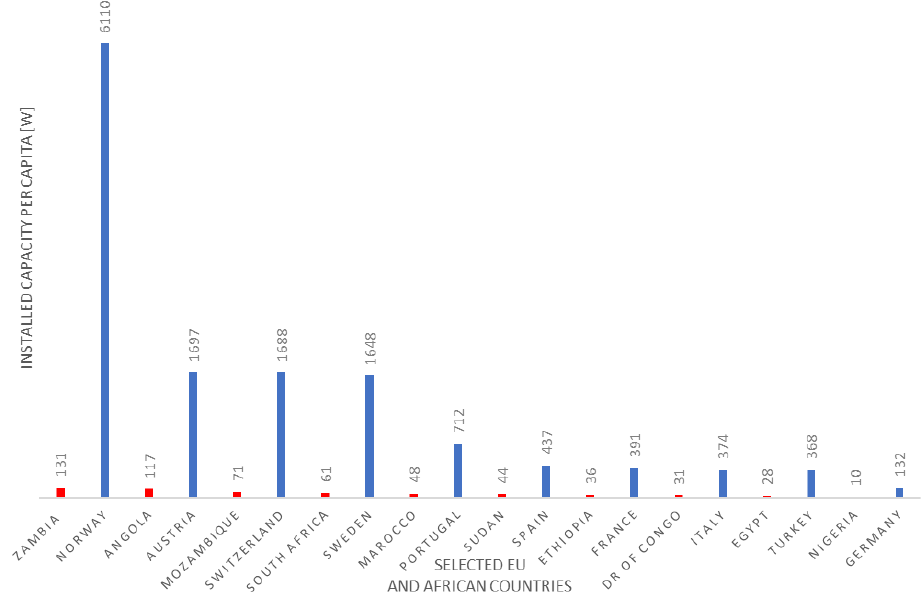
Figure 2. Comparison of the installed capacity per capita for the 10 countries with the highest hydropower production. Source: own